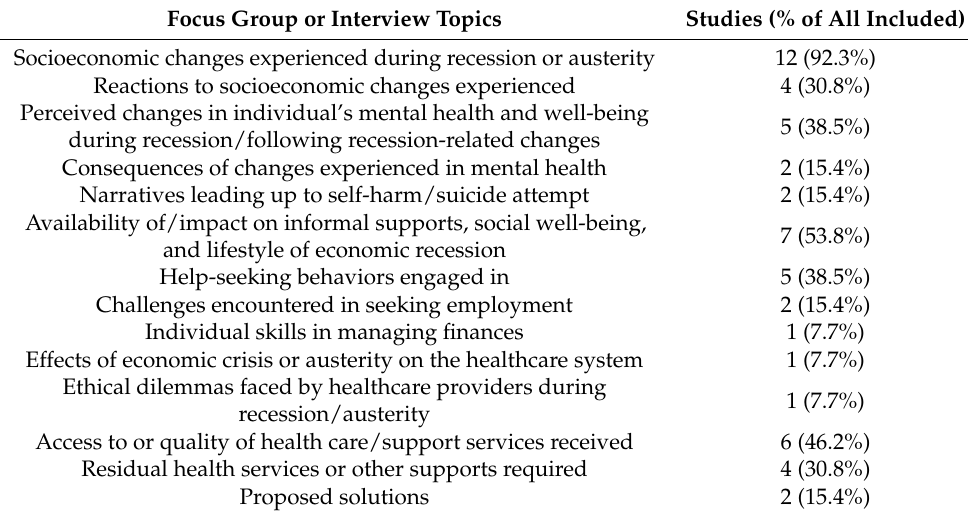
Table 2. Summary of topics included in interview and focus group